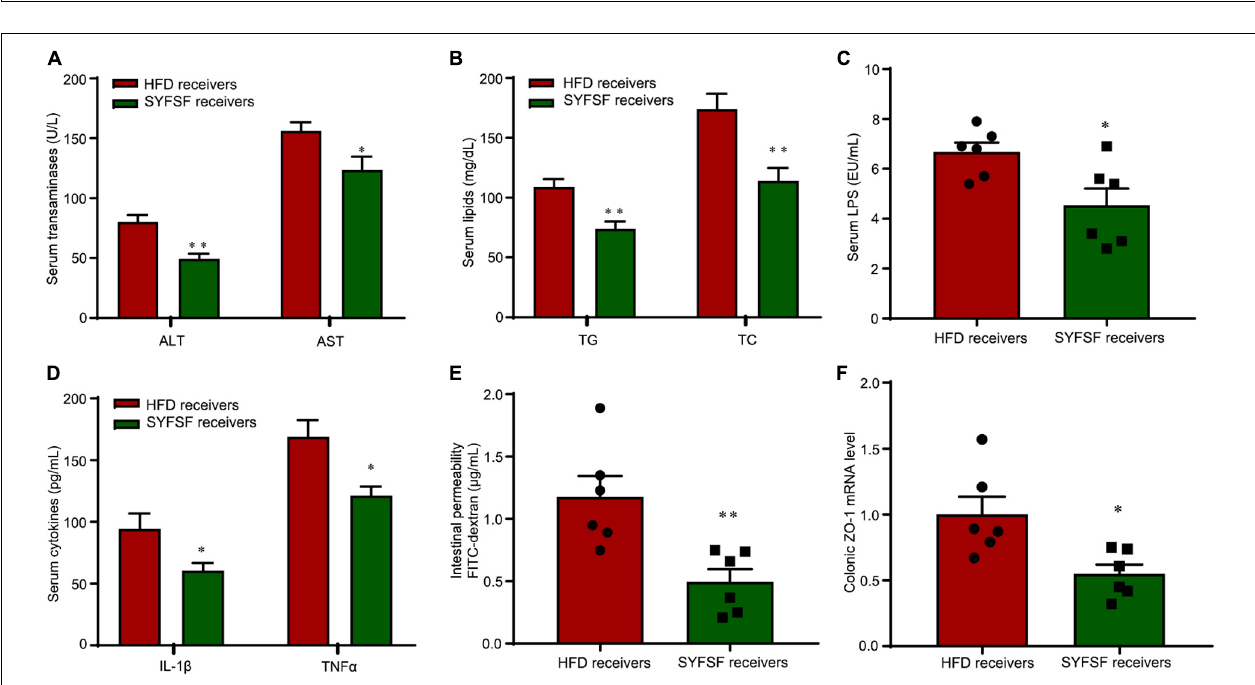
FIGURE 5 | FMT alleviates lipid dysregulation and improves gut barrier function in HFD-fed mice. (A–D) Serum ASL, ALT, TG, TC, endotoxin, IL-1 β , and TNF- α . (E) Intestinal permeability. (F) Expression of ZO-1 in proximal colon. ∗∗ P < 0.01, ∗ P < 0.05 vs. HFD receivers. n = 6 per group.